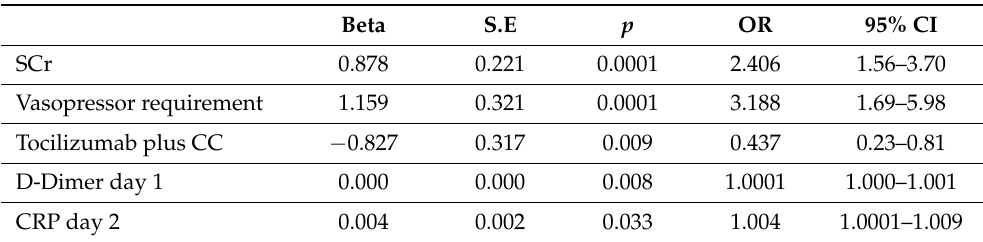
Table 4. Multivariate analysis of risk factors for